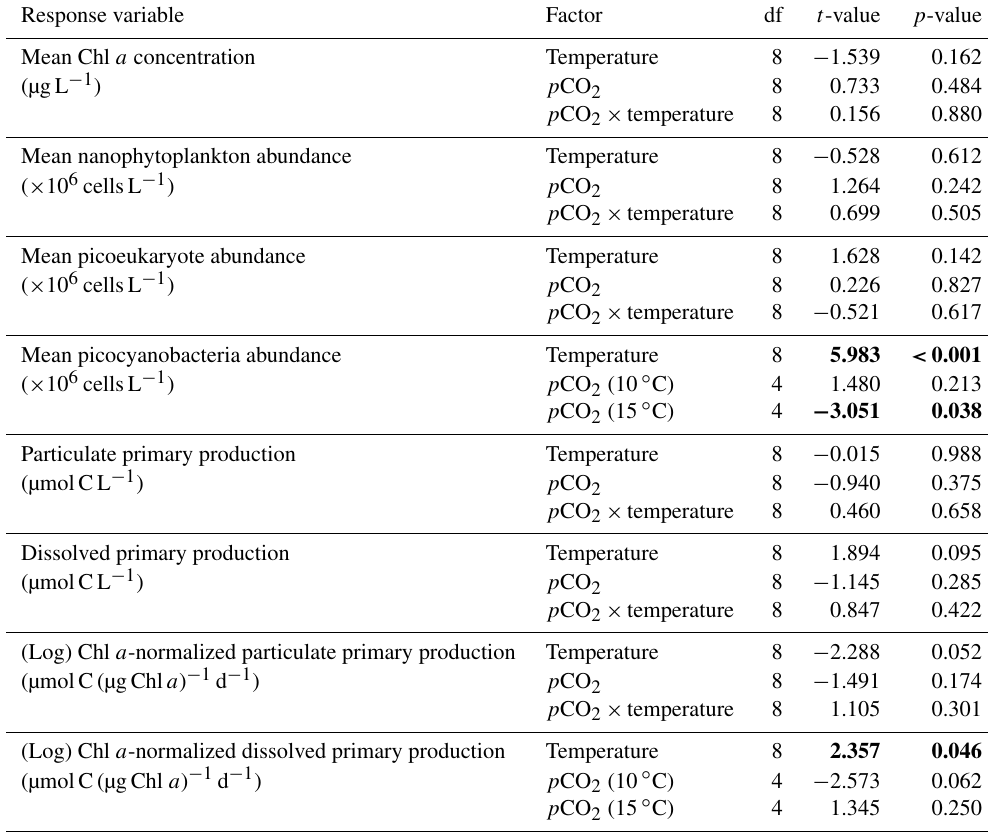
Table 4. Results of the generalized least squares models (gls) tests for the effects of temperature, p CO 2 , and their interaction during Phase II (day after maximum Chl a to day 13). Separate analyses with p CO 2 as a continuous factor were performed when temperature had a sig- nificant effect. Chl a concentration, nanophytoplankton abundance, picoeukaryote abundance, picocyanobacteria abundance, particulate and dissolved primary production, and Chl a -normalized particulate and dissolved primary production. Significant results are in